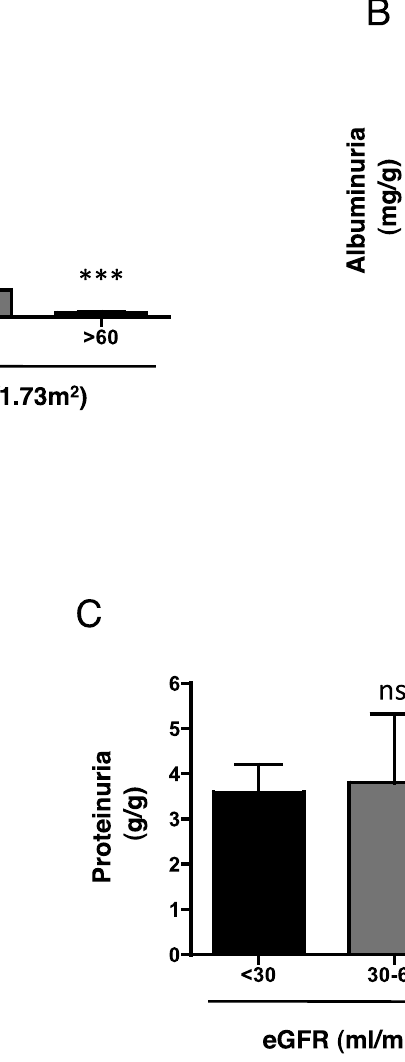
Figure 3. Distribution of proteinuria according to the estimated glomerular filtration rate. A , B , C . Histogram showing Alb (A), RBP (B), and total proteinuria (C) values according to the level of eGFR. Protein concentrations are expressed as the mean 6 sem. **p , 0.01, ***p , 0.001 compared to eGFR , 30 ml/min, using Student’s T test.